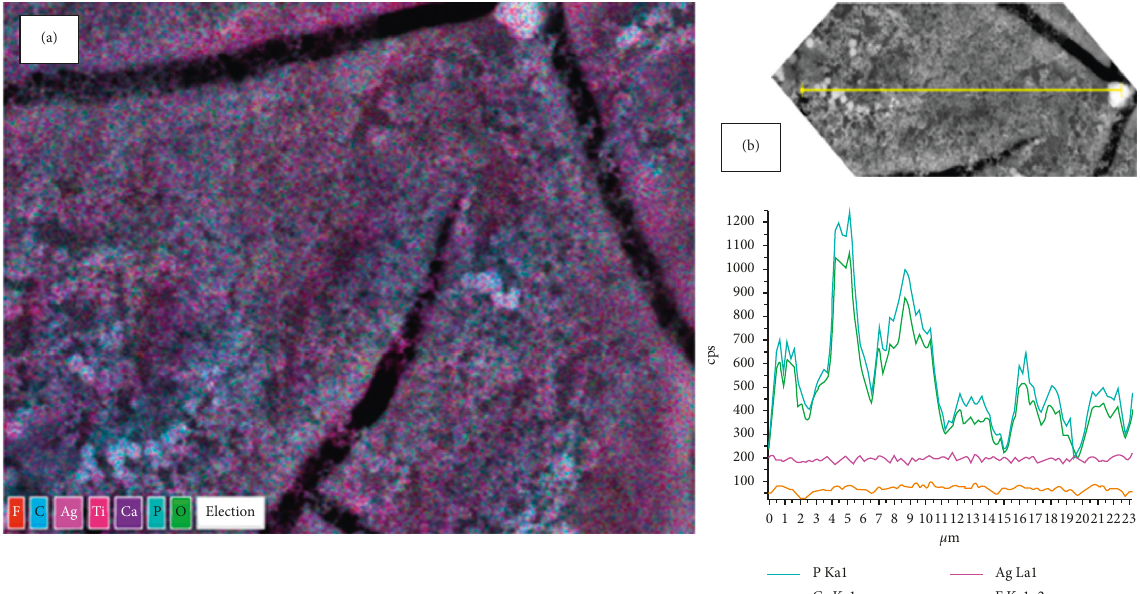
Figure 5: (a) Top-down SEM image and overlaid EDS elemental map and (b) EDS line scan obtained from the same region as (a) for coprecipitated Ag and HAp on TiO 2 NT disks. Table 2: Elemental weight percentage of surface materials on the TiO 2 NTdisks after deposition of Ag-doped HAp obtained using mapping and line scan EDS. Element Layered EDS mapping (wt.%) Line scan EDS